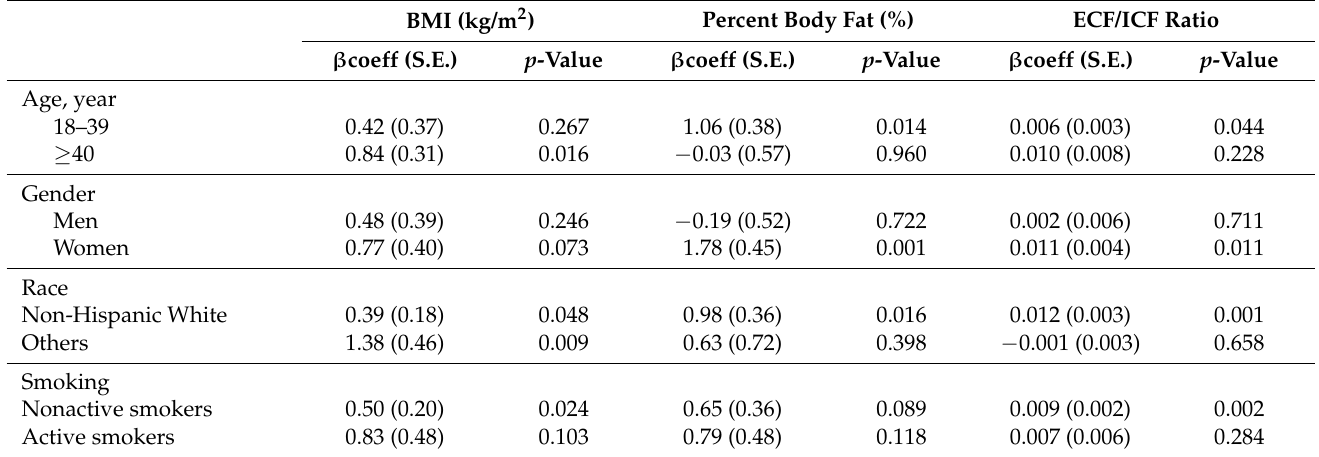
Table 5. Linear regression coefficients (S.E.) between ln- Σ DEHP and body composition parameters in different subpopulations of sample subjects with results weighted for sampling